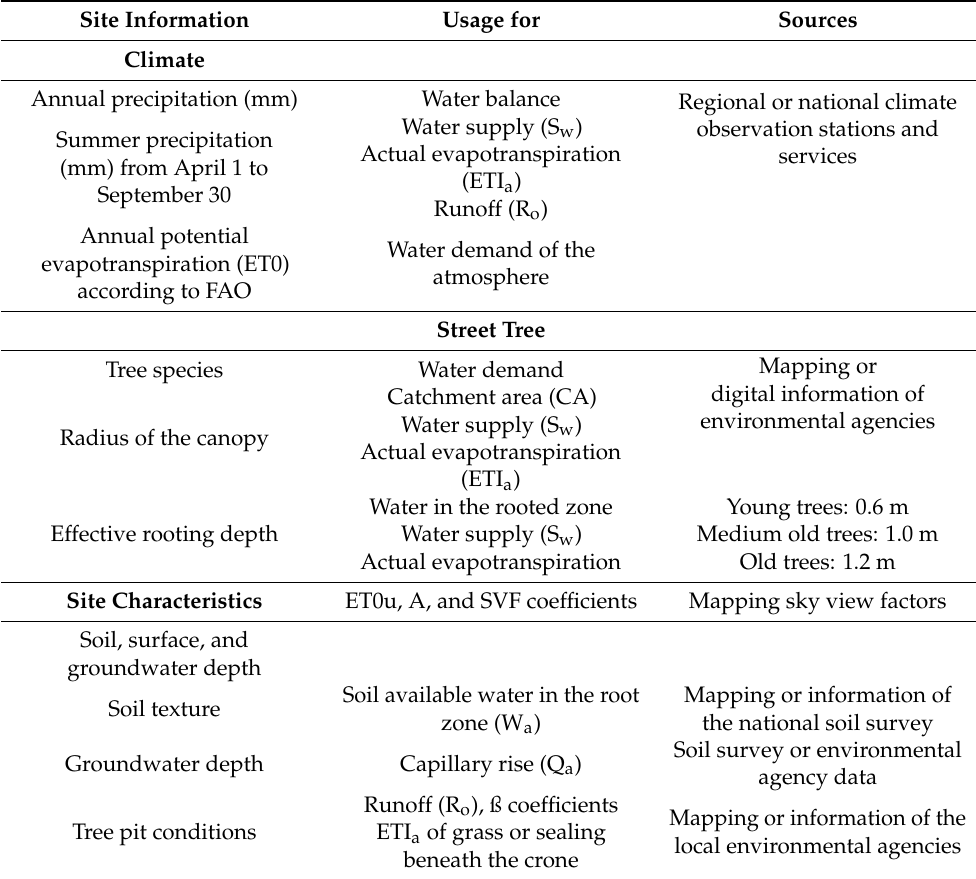
Table 2. Site information needed for predicting water supply and actual evapotranspiration of street trees by